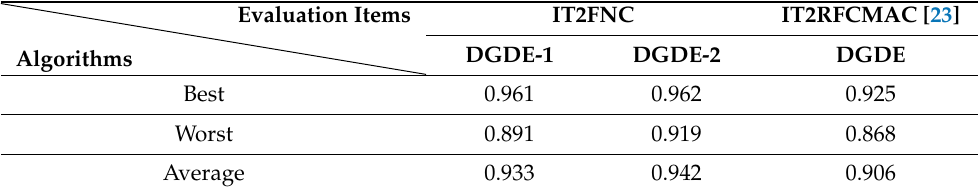
Table 4. Performance comparison of different network